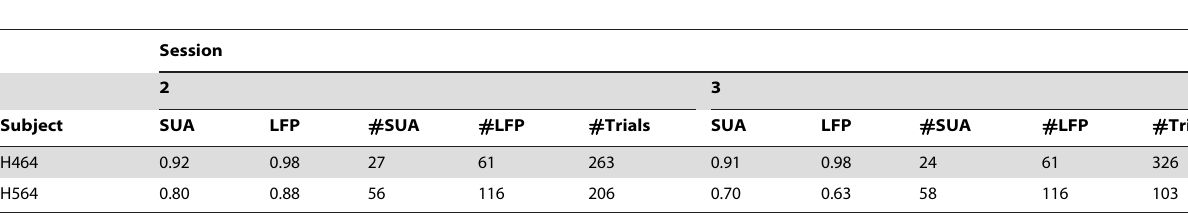
Table 2. Decoding accuracy ( r T) with SUA and LFP in single sessions.